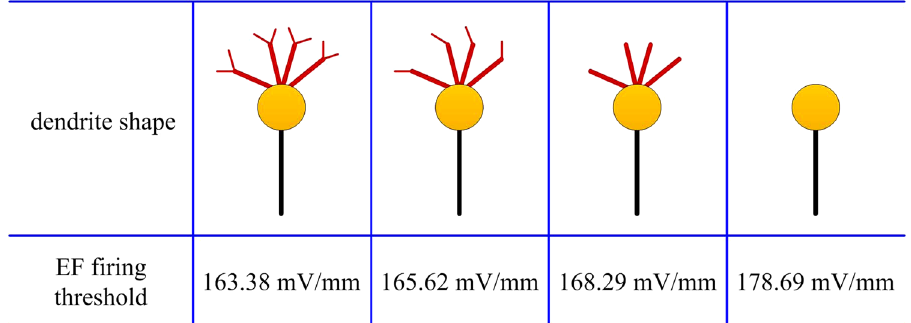
Figure 5. Dendrite structures affect EF firing threshold in artificial neuron.